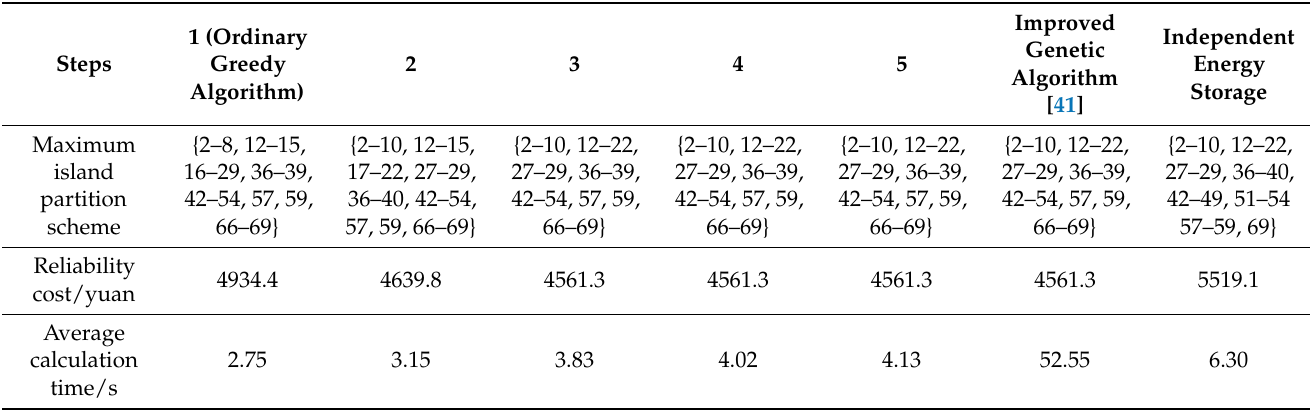
Table 3. Maximum island partition scheme with variable